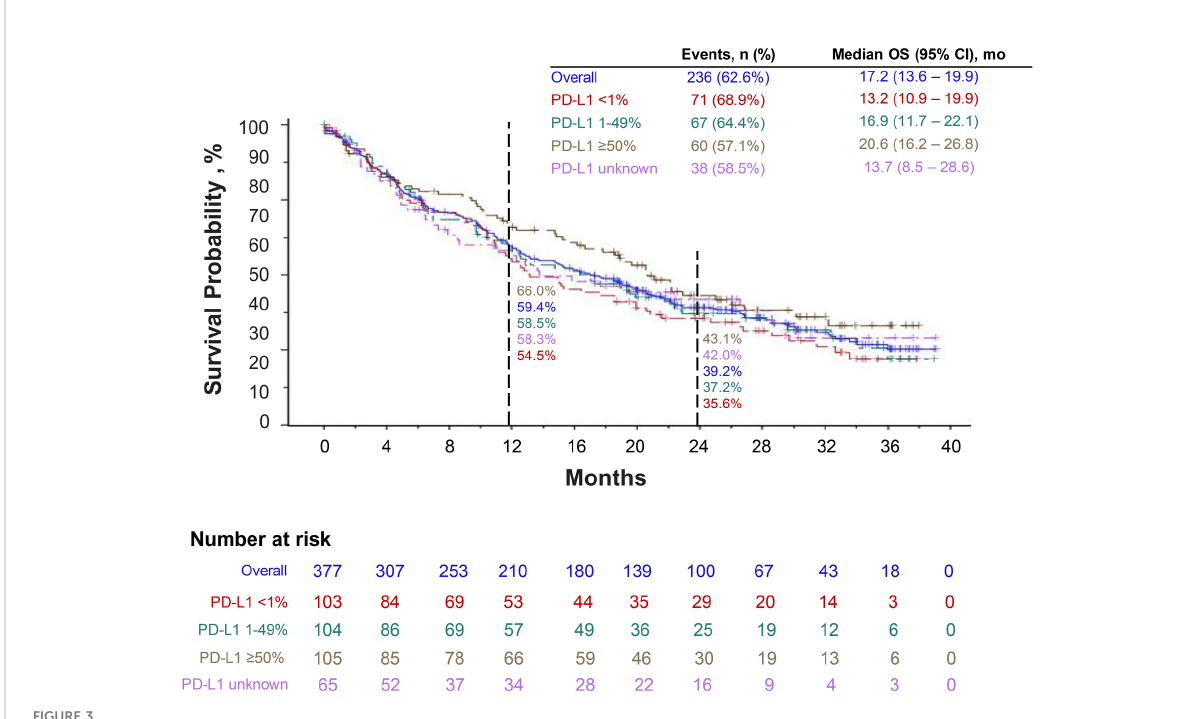
FIGURE 3 Overall survival with pembrolizumab plus pemetrexed and